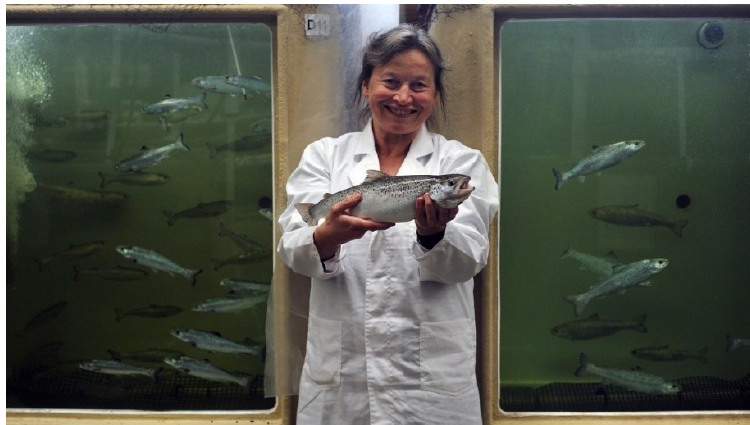
Figure 7. Barbara F. Nowak received her PhD degree in Aquatic Toxicology from the University of Sydney (Australia) in 1991 and her DSc (“Habilitation”) from the University of Agriculture, Szczecin (Poland) in 2004. At present she is professor in Aquatic Animal Health at the Institute of Marine and Antarctic Studies, University of Tasmania, Launceston (Australia). Her group is focusing on health of farmed fish in particular interactions between host, pathogen and environment. She is the (co)author of an impressive number of publications on Amoebic Gill Disease (AGD) in salmon, tuna health, fish immunology and